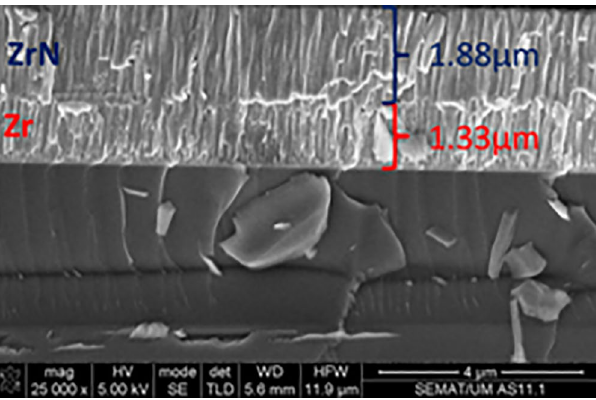
Figure 1. FESEM cross-section image of Zr/ZrN bilayer using a current density of 1.8 A with 0 and 11 sccm of nitrogen for Zr and ZrN.